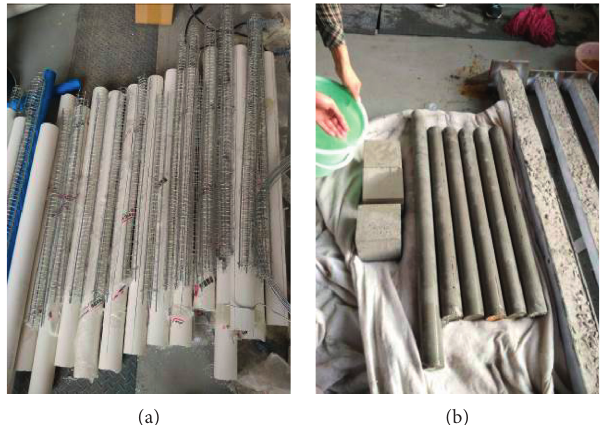
Figure 3: Physical diagrams of the model piles: (a) PVC pipe and wire cage; (b) maintenance model